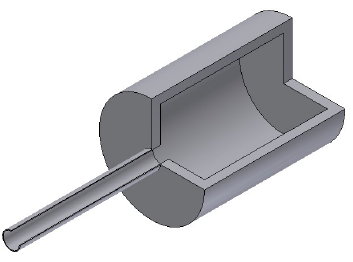
Figure 2. A sample container for compatibility testing.